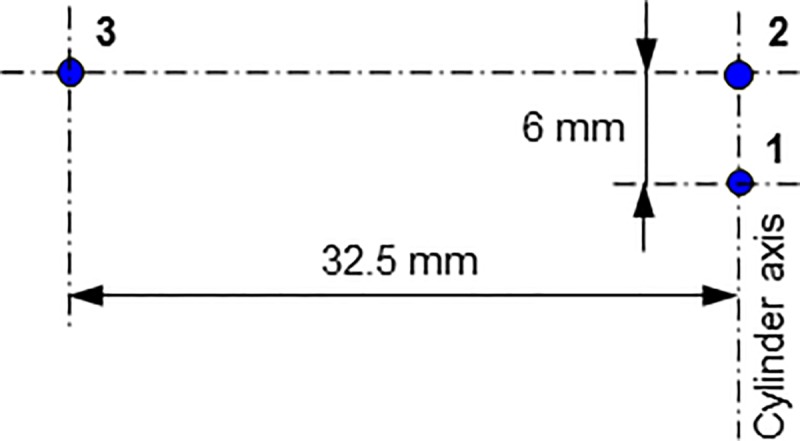
Arrangement of three simple probes with a diameter of 0.1 mm.